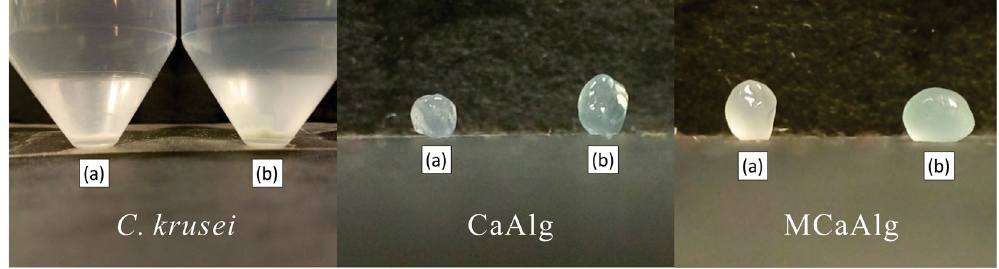
Figure 1. C . krusei , CaAlg and MCaAlg ( a ) before and ( b ) after copper(II)